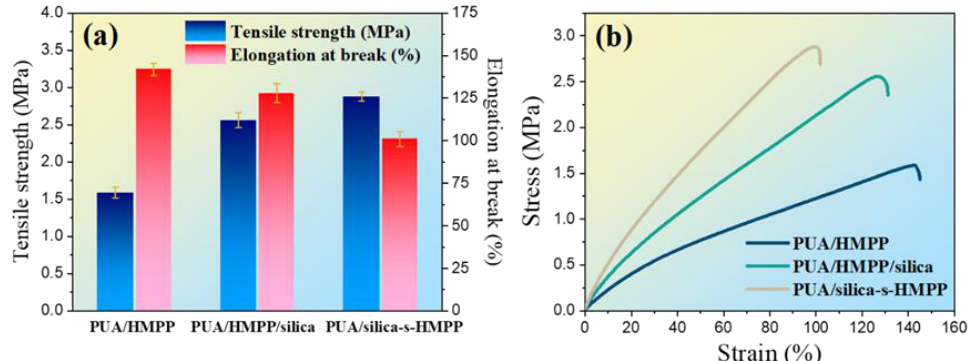
Figure 4. Mechanical properties of PUA composites: ( a ) tensile strength and elongation at break, ( b ) stress vs. strain curves of PUA composites.